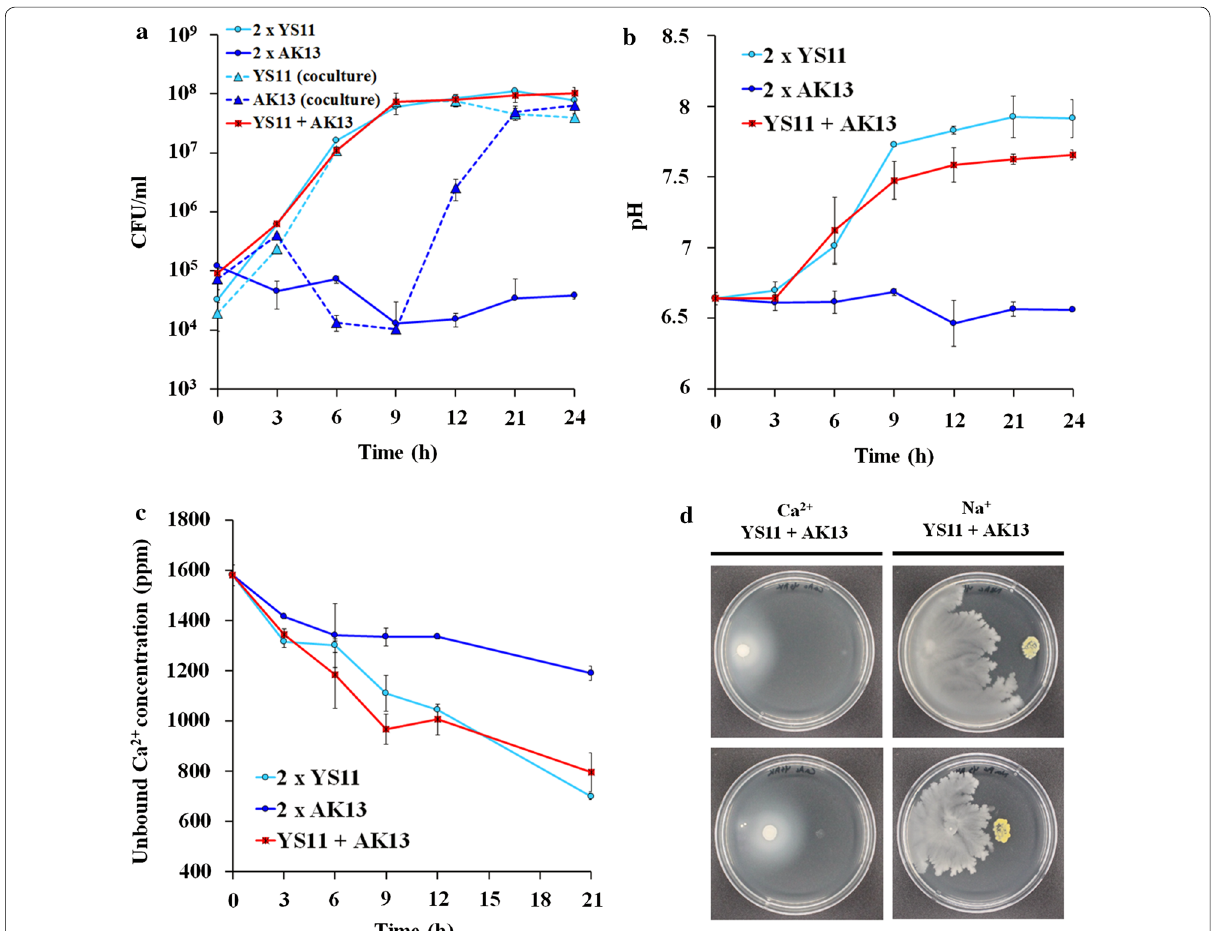
Fig. 3 Growth, pH changes, and calcium utilization in MICP-inducing conditions with YS11, AK13 alone, and YS11 CFU growth of YS11, AK13, and YS11 AK13, the growth of AK13 is facilitated by coculture with YS11. b pH changes in YS11, AK13 single culture, + and YS11 AK13 coculture are shown. c Unbound Ca 2 + concentrations in supernatants of YS11, AK13 single culture, and YS11 + measured. d Induced growth of AK13 from coculture with YS11 in agar plate